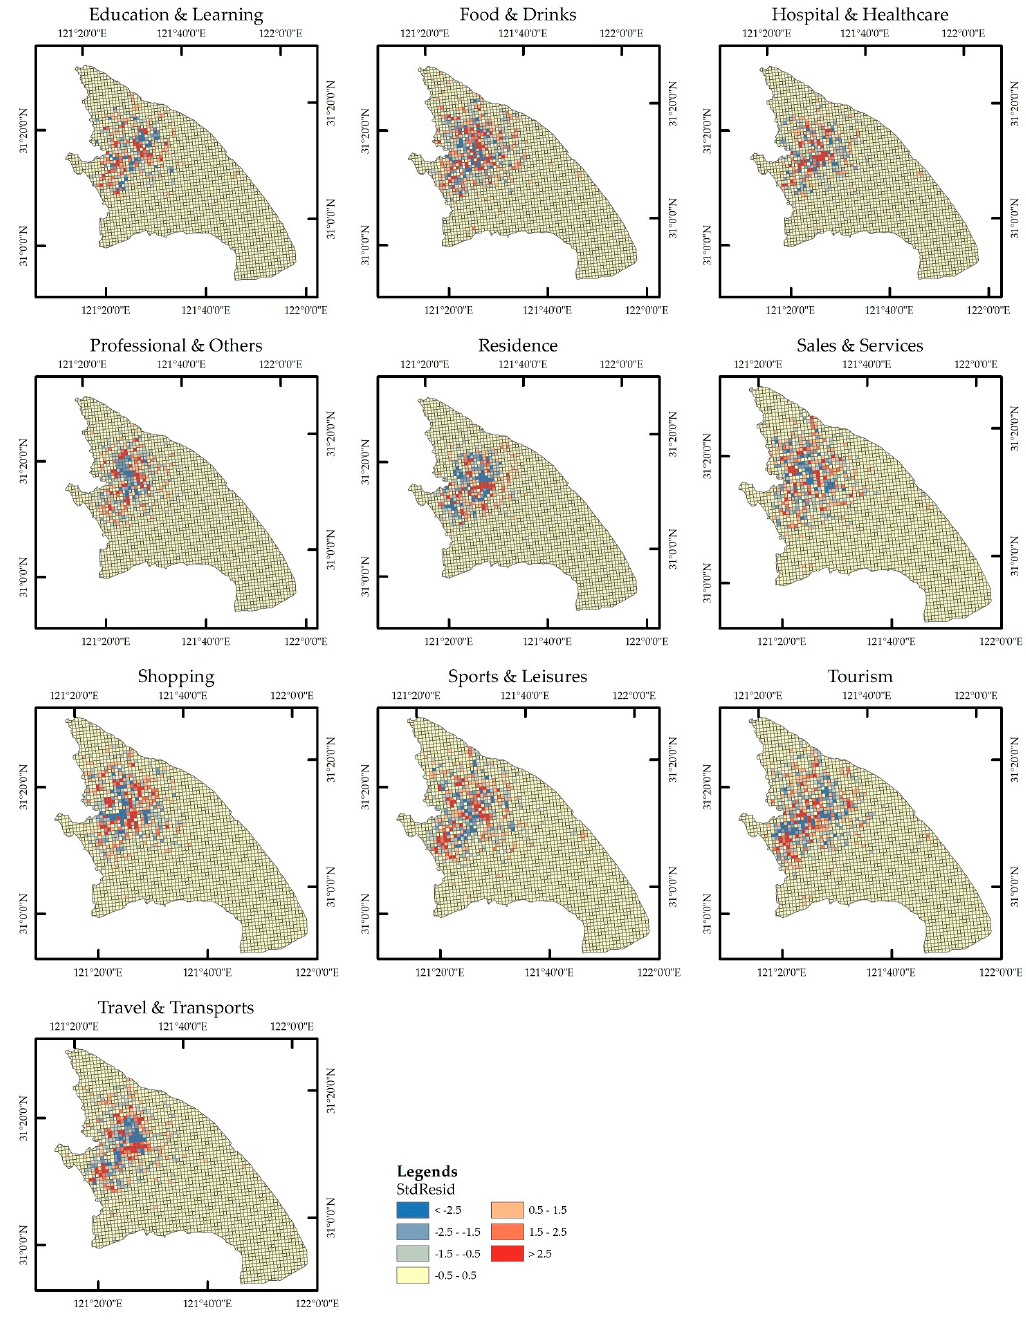
Figure 15. Spatial distribution of activities during weekdays in Shanghai.